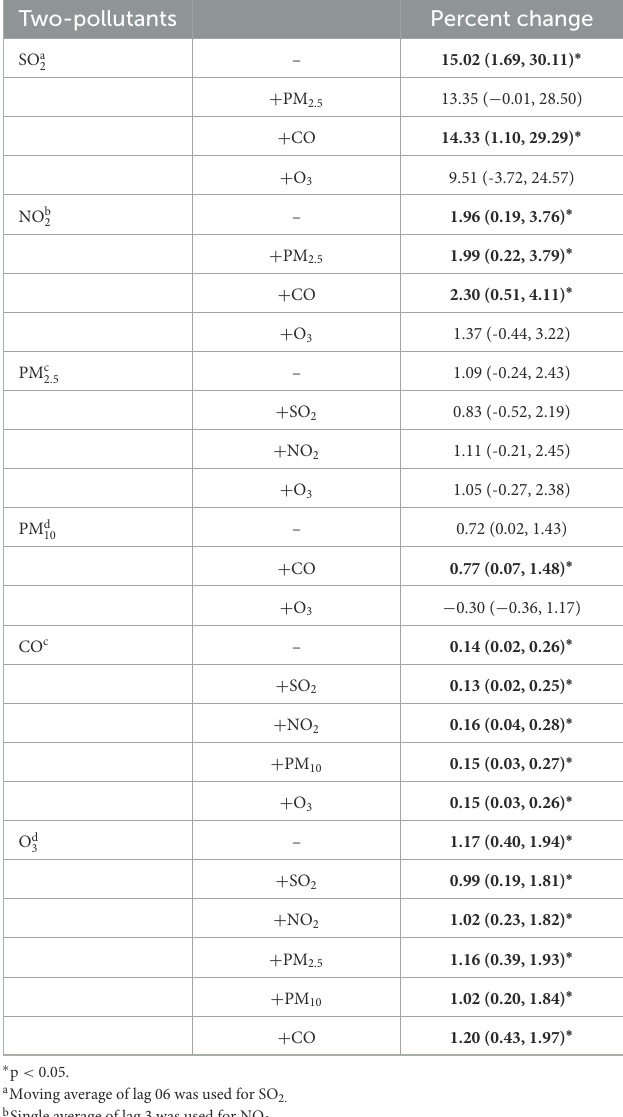
TABLE 3 Percent change (%, mean and 95% CI) in EDVs for urolithiasis in two-pollutant models. Two-pollutants Percent